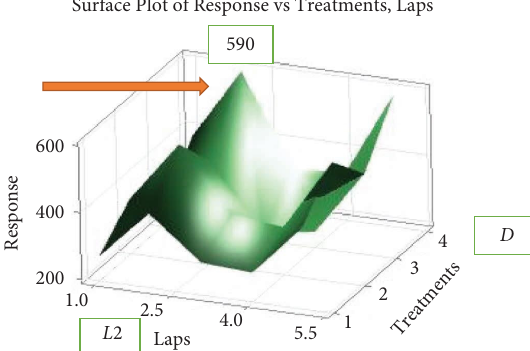
Figure 8: Surface plot of response vs. treatments vs. labs.